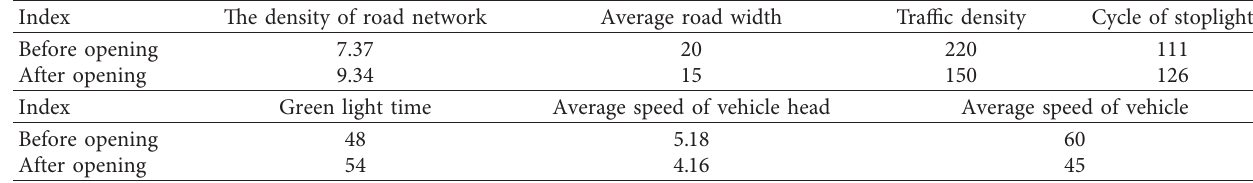
Table 3: Main parameter data of Xiamen Songbai community before and after opening.